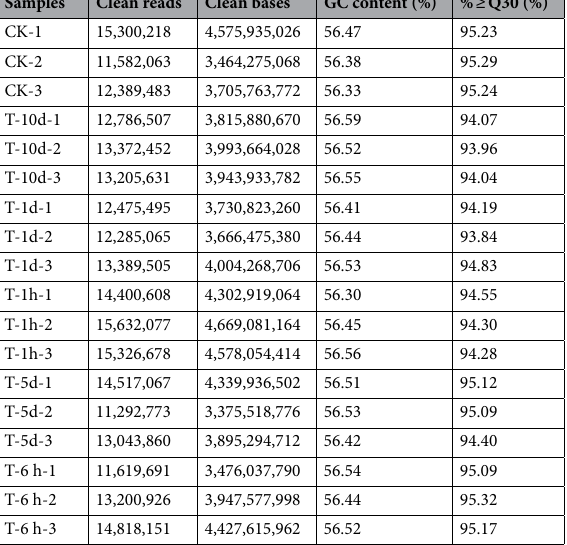
Table 1. Sequencing data Statistics.